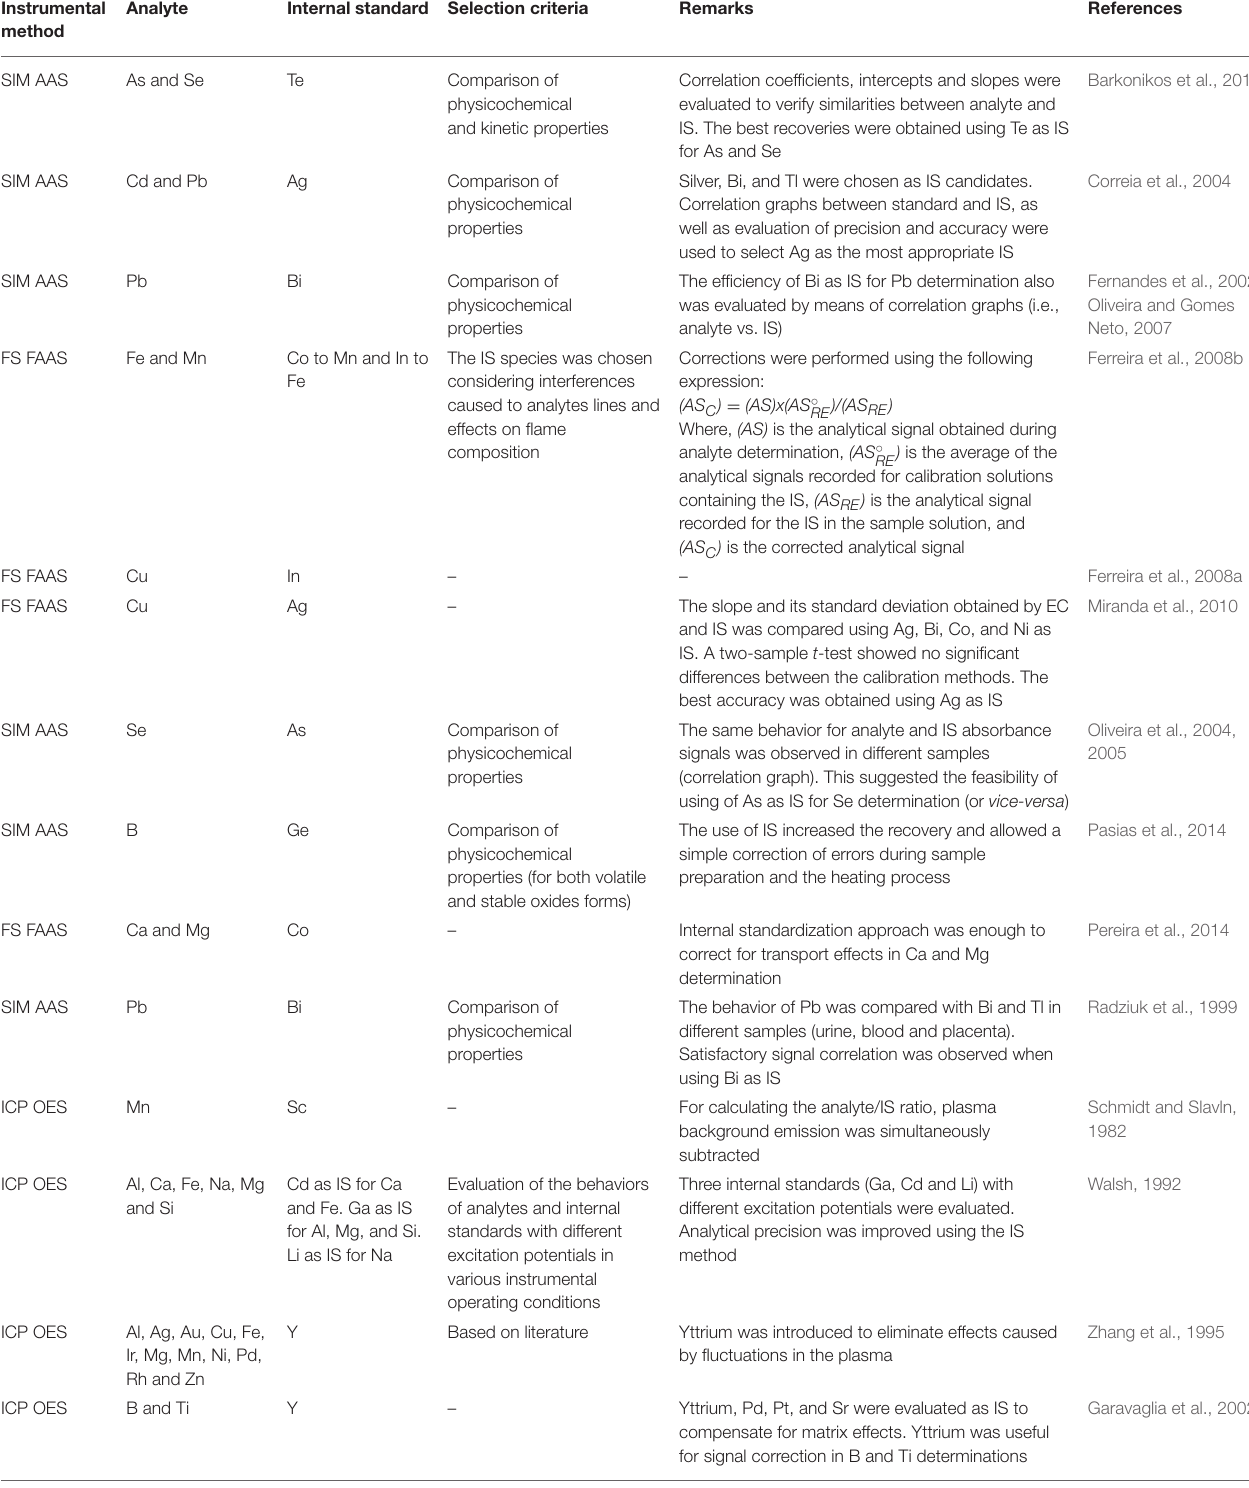
TABLE 2 | Internal standardization applied to SIM AAS, FS FAAS, ICP OES, and ICP-MS, and the selection criteria used for choosing the IS species. Instrumental